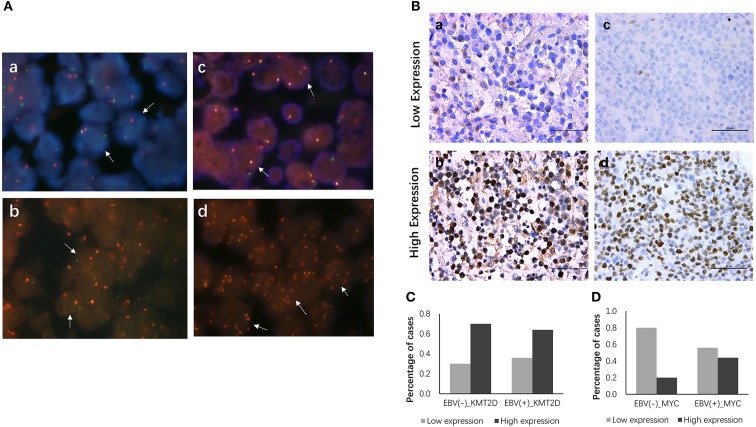
FISH and IHC staining of EBV+ and EBV negative DLBCL specimens. Example of FISH performed on EBV+ and EBV negative DLBCL (A), FISH assay reveals rearrangement at the c-MYC (a), BCL2 (b) and BCL6 (c) loci using the dual-color break-apart rearrangement probes, break-apart signals in DLBCL nuclei are highlighted exemplarily by white arrows; increased copies of BCL6 by FISH (d). Immunohistochemistry staining for KMT2D and MYC in EBV+ and EBV negative DLBCL specimens (B), (a) Low expression of KMT2D (IHC, ×400); (b) High expression of KMT2D (IHC, ×400); (c) Low expression of MYC (IHC, ×400); (d) High expression of MYC (IHC, ×400). (C) Bar chart showing the percentages of KMT2D expression in EBV+ and EBV- negative DLBCL cohorts. (D) Bar chart showing the percentages of MYC expression in EBV+ and EBV negative DLBCL cohorts.